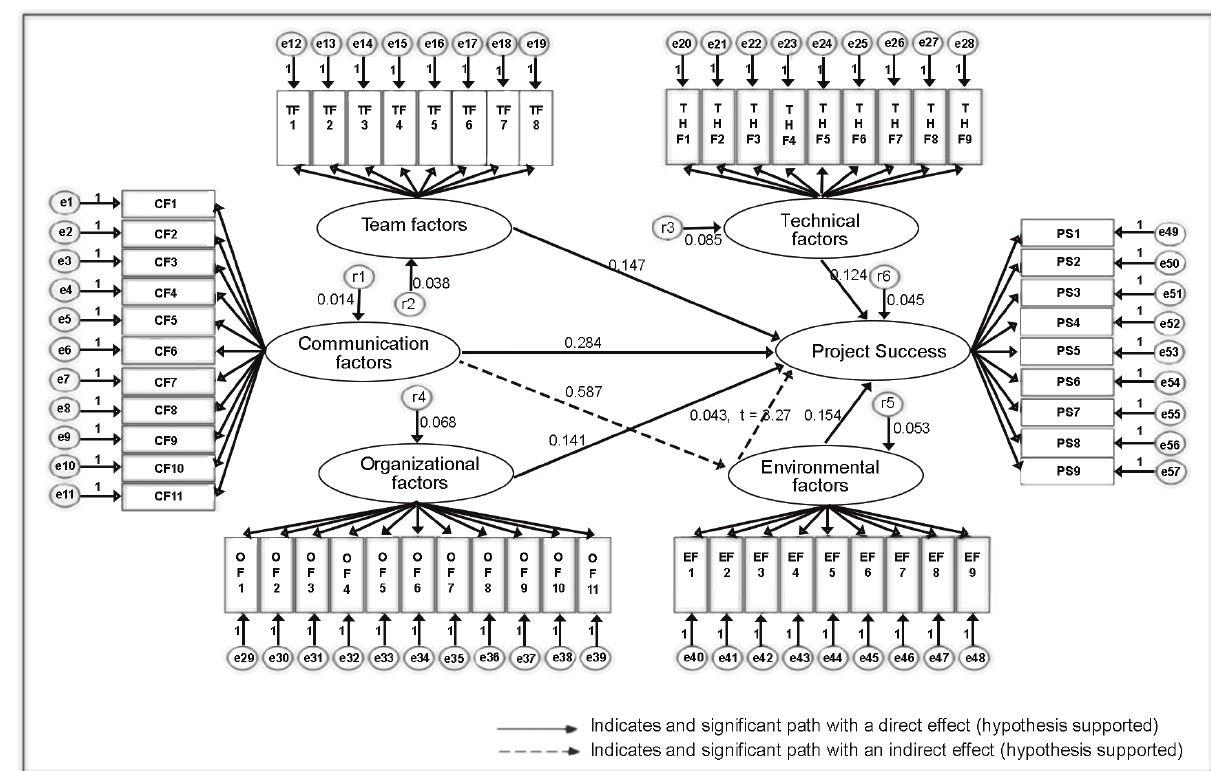
Figure 3. Final SEM of interrelationship framework between critical success factors and project